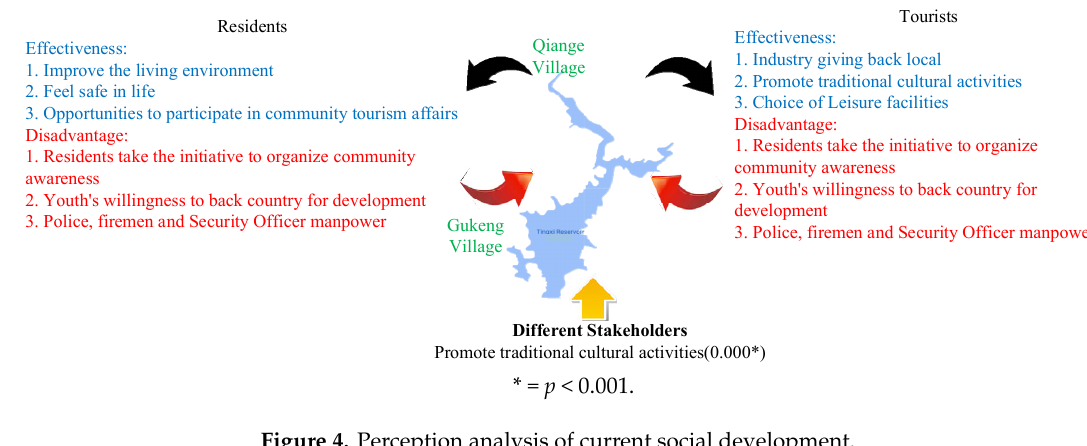
Figure 4. Perception analysis of current social development.